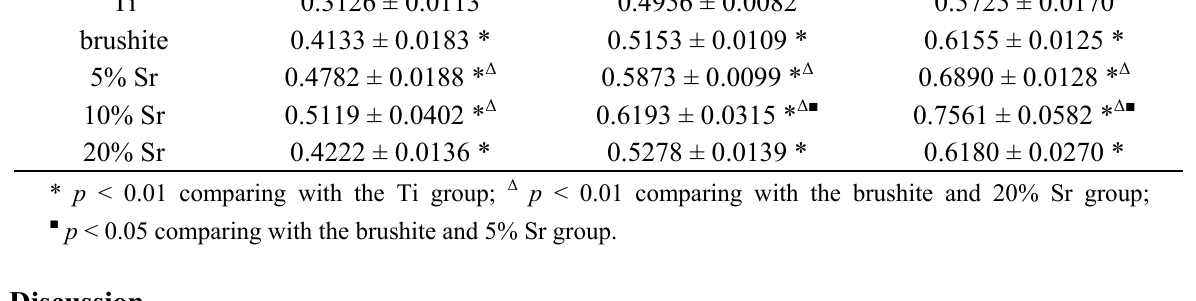
Table 2. OD value of osteoblast cultured in the Sr-brushite extracted fluid ( n = 6).